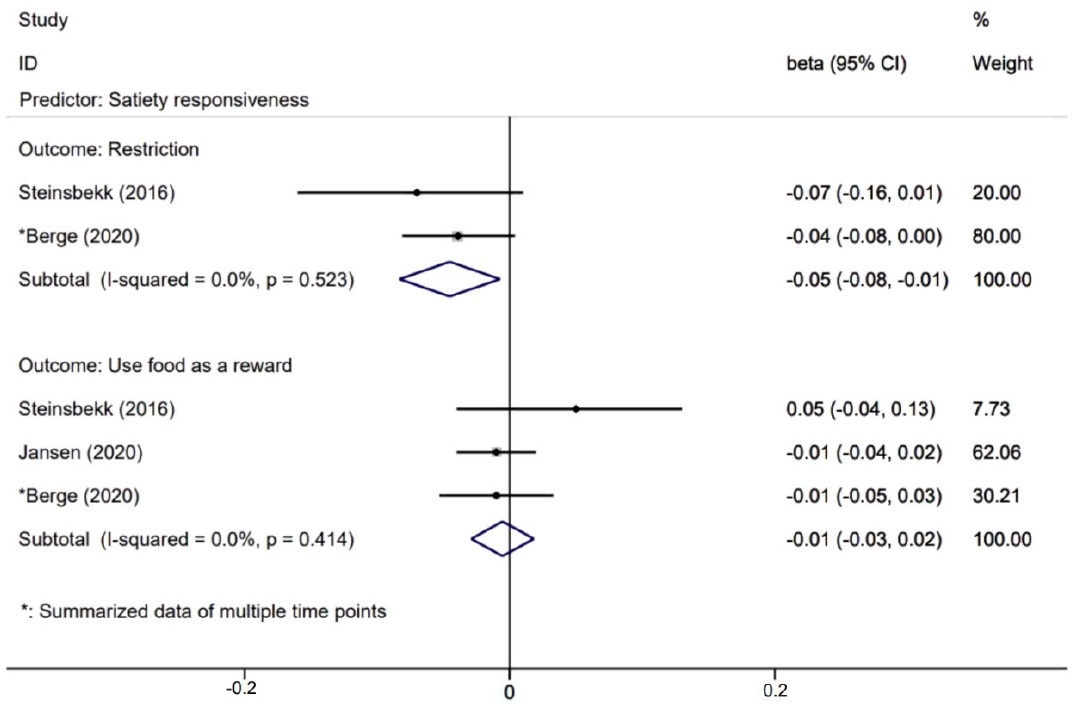
Figure 8. Effects of child enjoyment of food on parental non-feeding practices. However, all five synthesized results were only based on available data from no more than three studies and heterogeneity between studies was also considerable ( I 2 between 29.7% and 55.7%). 4. Discussion The aim of this systematic review and meta-analysis was to summarize available ev- idence about the bidirectional relationships between parental non-responsive feeding